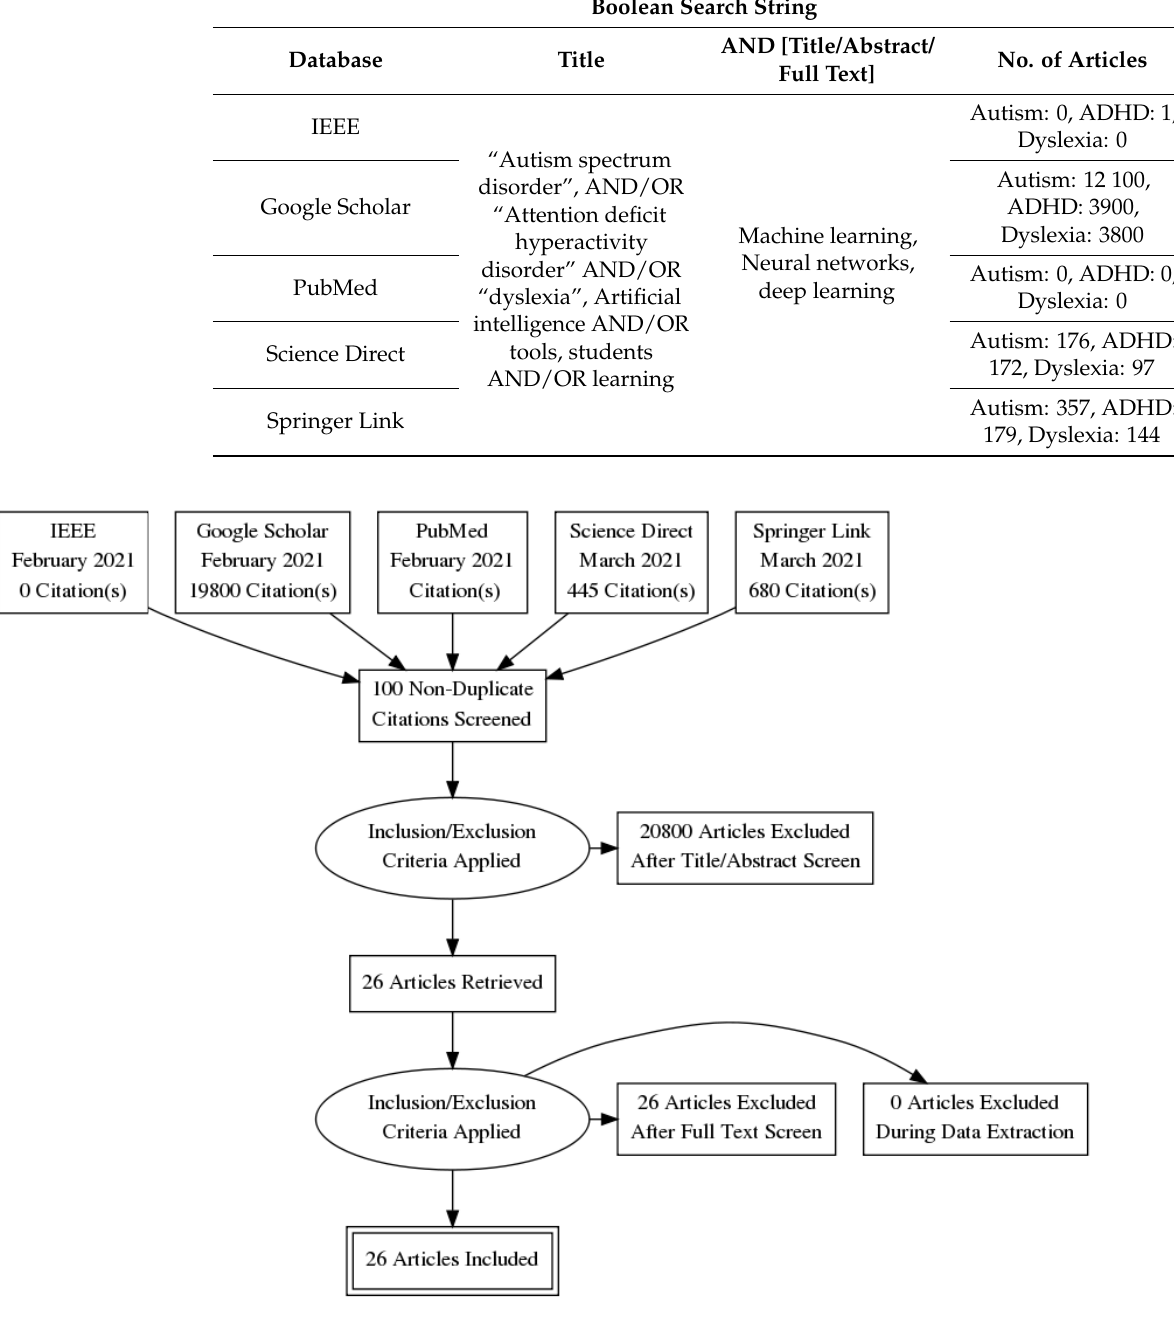
Figure 8. Flowchart detailing the use of PRISMA guidelines for selection of relevant articles.